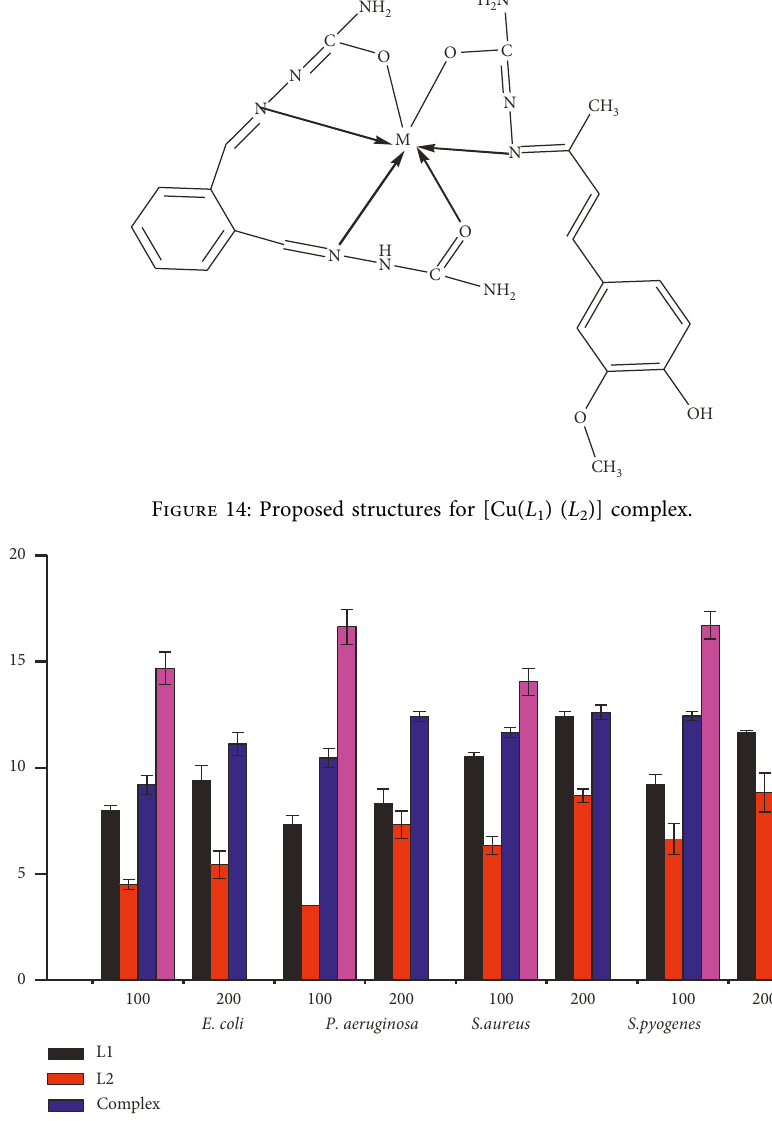
Figure 15: Inhibition zone plot of the samples on bacterial growth (mean ± SD).